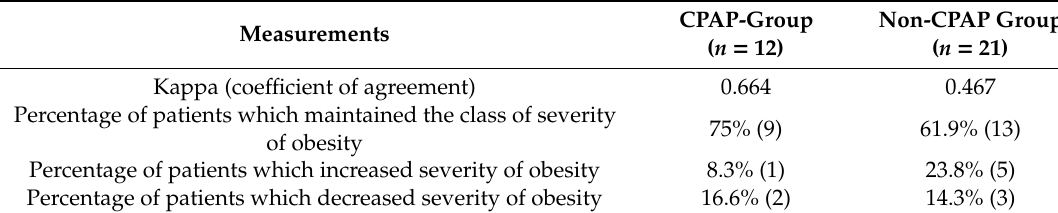
Table 4. Agreement of classification of the severity of obesity using BMI categories between initial and follow-up evaluations.